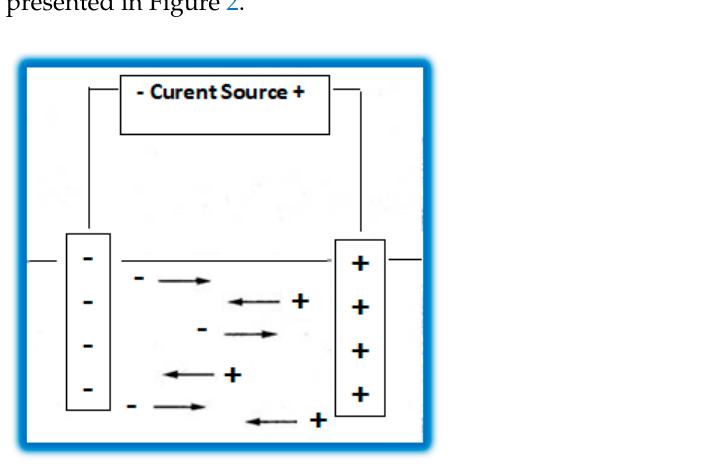
Figure 2. The principal diagram of the method of determining the electrical conductivity.